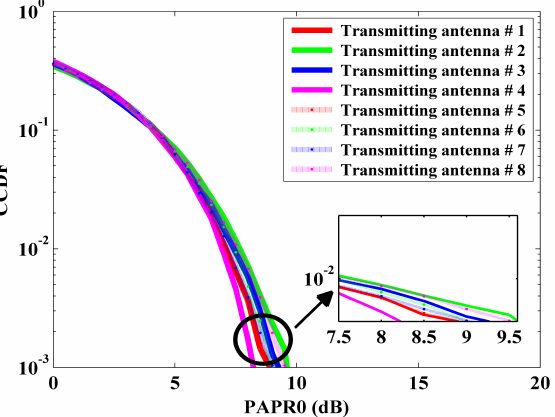
Figure 17. Estimated complementary cumulative distribution function (CCDF) of peak-to-average power ratio (PAPR) at different ground transmitting channels of the proposed simulated system.